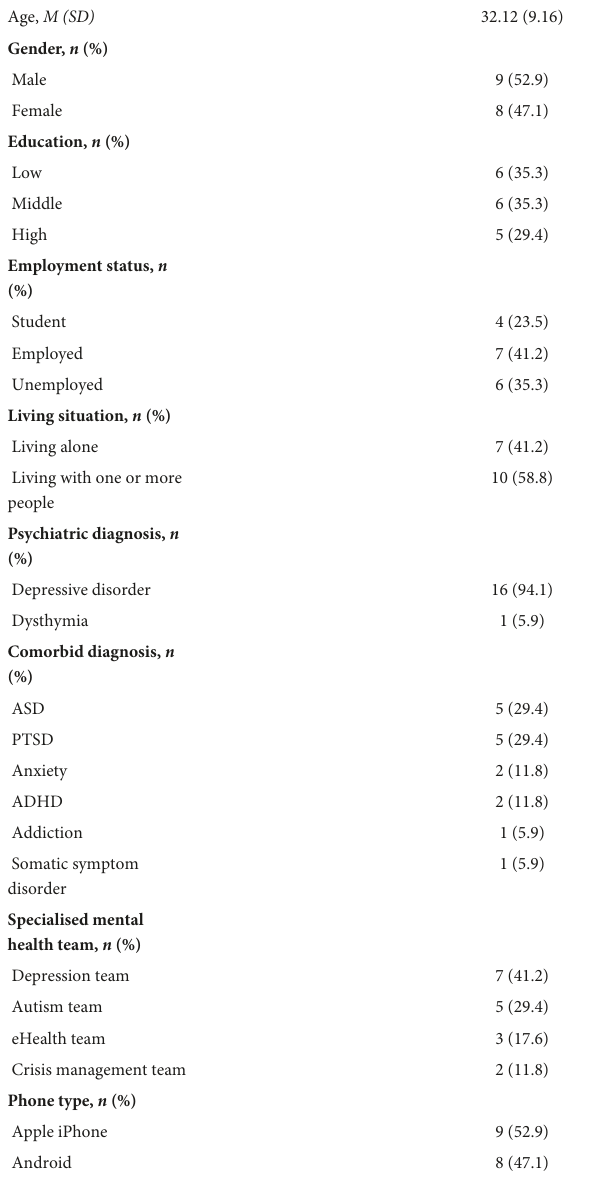
TABLE 2 Demographics characteristics of patients.